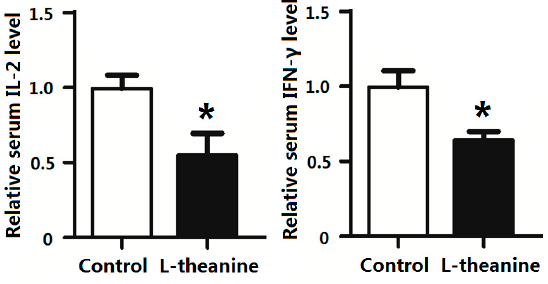
Figure 4. Effects of L -theanine on the relative expression of IL-2 and IFN- γ . Note: Values are means ± SEM. vs. control group, * p ≤ 0.05. Int. J. Mol. Sci. 2018 , 19 , x FOR PEER REVIEW